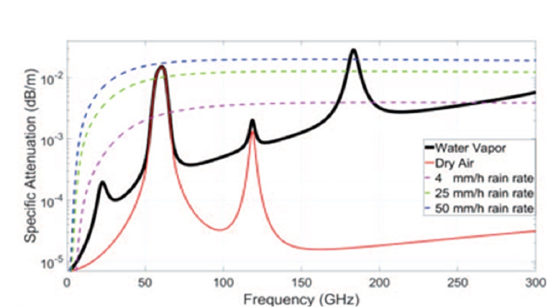
Figure 2. Results of diffuse scattering measurements at 60 GHz